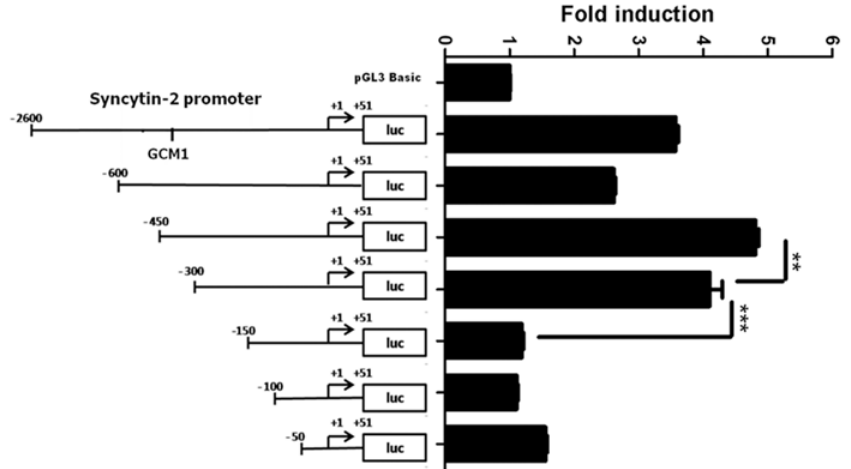
Fig 1. Identification of Syncytin-2 promoter regions responsive to forskolin induction in BeWo cells. The first 2600 bp region positioned upstream of the Syncytin-2 transcription initiation site in addition to the first 51 nucleotide of exon 1 were cloned upstream of the luciferase reporter gene. The resulting vector pGL3/ 2600 and successive 5 ’ deletion mutants vs. the control vector pGL3Basic (400 ng) were co-transfected with 200 ng pRcActin-LacZ in BeWo cells. Cells were either left untreated or treated with 50 μ M forskolin. At 12 h post treatment, cells were harvested and assayed for luciferase activity in triplicates. Luciferase activities were normalized over β -galactosidase activity as the mean ± S.E.M. from three independently transfected cells in the same experiment. Results are shown as mean of fold induction of treated over untreated cell samples and are representative of four independent experiments ( ** p < 0.01 *** p < 0.001). The position of the previously identified GCM1-binding site and the transcription initiation site are both shown within the Syncytin-2 promoter in the pGL3/2600